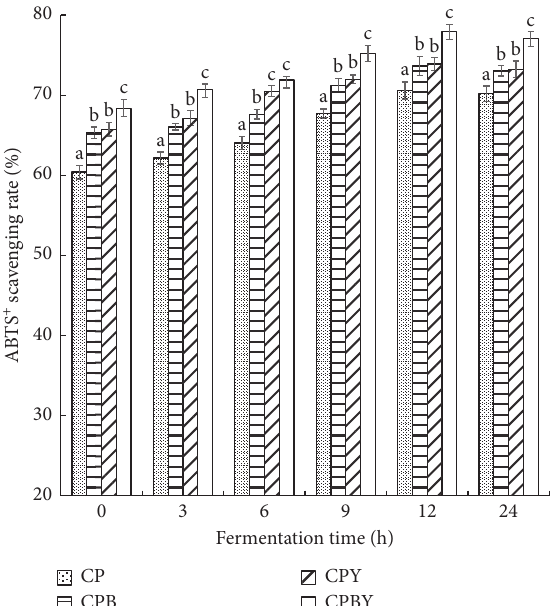
Figure 5: ABTS+free radical scavenging rate of four samples at different fermentation times. All the values are expressed as mean ± SD ( n � 3). Means with different lowercase letters indicate a significant difference of four group samples at the same fermentation time ( p < 0 . 05). CP, chickpea fermentation milk; CPB, chickpea fermentation milk with enzyme hydrolysis; CPY, chickpea yam fermentation milk; CPBY, chickpea yam fermentation milk with enzyme